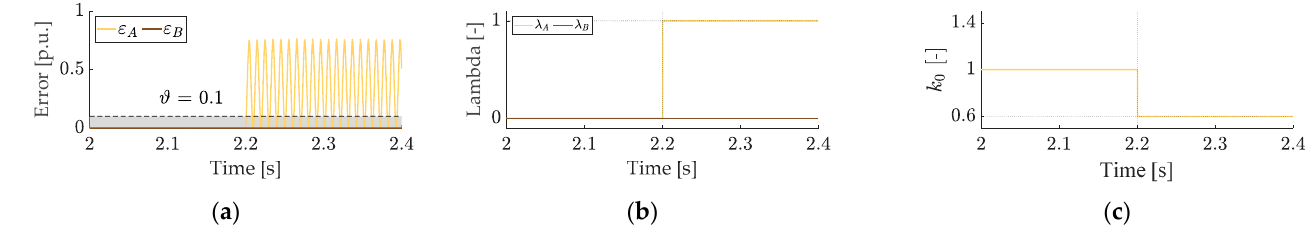
Figure 16. CS fault detection ( a ), localization ( b ), and change in k 0 coefficient in G matrix ( c ).